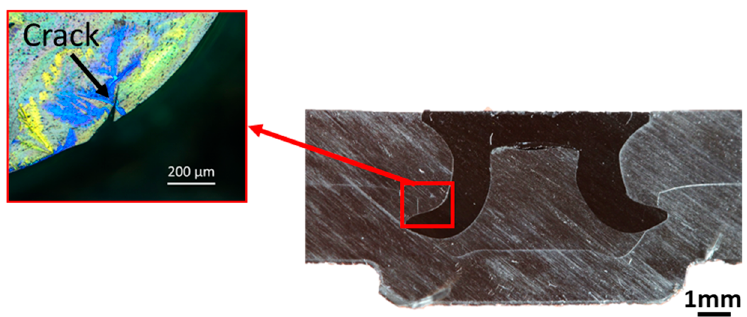
Figure 4. Crack appearing in an upper sheet of a SPR joint with a highly flared (over-flow) rivet. This joint was achieved using ϕ 10 mm die with a depth of 1.2 mm and a rivet with a length of 7 mm and hardness of 420 Hv with a velocity of 360 mm/s.